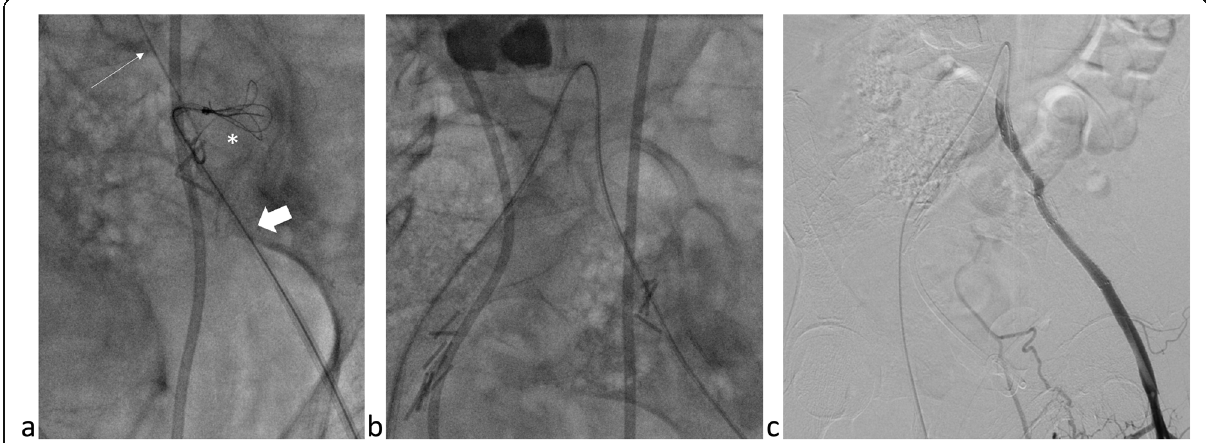
Fig. 3 A Fluoroscopic image a showing the microcatheter and microwire from the right sided arterial access (thin arrow) and the snare from the left sided arterial access (thick arrow) together within the extra-vascular space (asterisk) followed by successful snaring and through-and-through access b across the pseudoaneurysm. An arterial phase angiogram c of the left external iliac artery following deployment of the covered stents shows exclusion of the pseudoaneurysm with no contrast